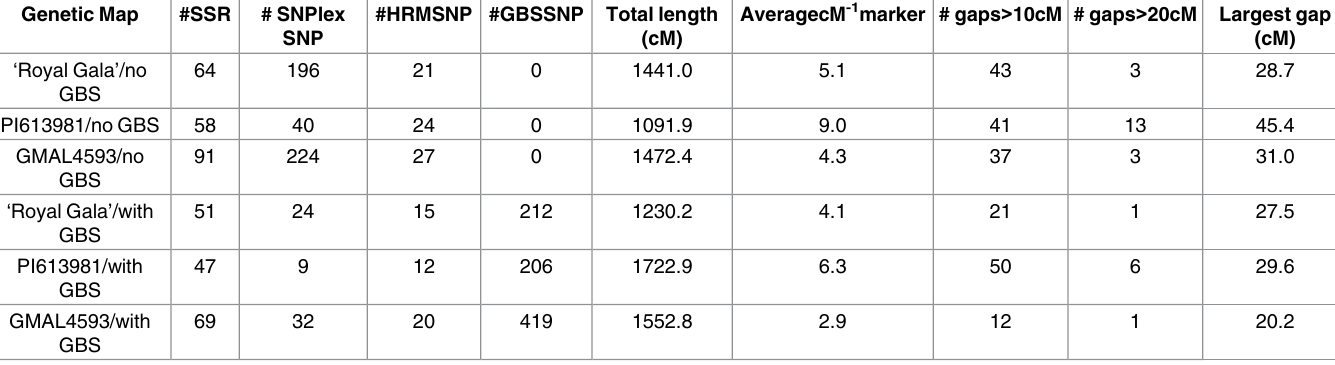
The first maternal (‘Royal Gala’), paternal (PI613981) and combined population maps were constructed using 171 individuals of the population. Because GBS data was not availablefor 2 of the 171 mapped individuals, maps containing GBS data (2 nd group of three maps) were constructed using 169